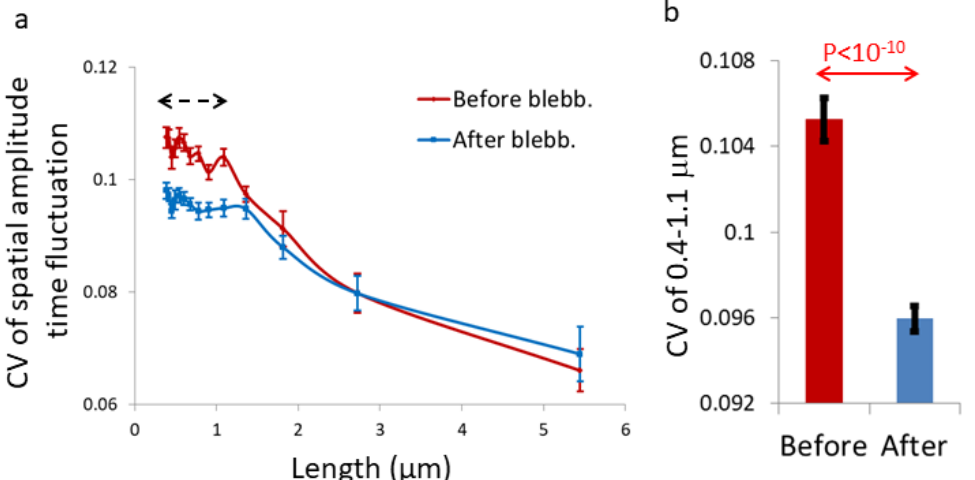
Figure 6. Temporal fluctuations (measured by the coefficient of variation (CV)) of the spatial amplitude in 31 live cells highlighted with Ca ++ -Fluo-4 before and after blebbistatin treatment. ( a ) Average CV values of the temporal fluctuations of the spatial intensity amplitudes in the cells before blebbistatin treatment, and of the same cells after 10 µ M blebbistatin treatment. ( b ) Average CV values of the spatial amplitudes in the range of 0.39–1.09 µ m in the cells before and after blebbistatin treatment. Error bars in ( a , b ) are SEM and p -value is shown in ( b ).